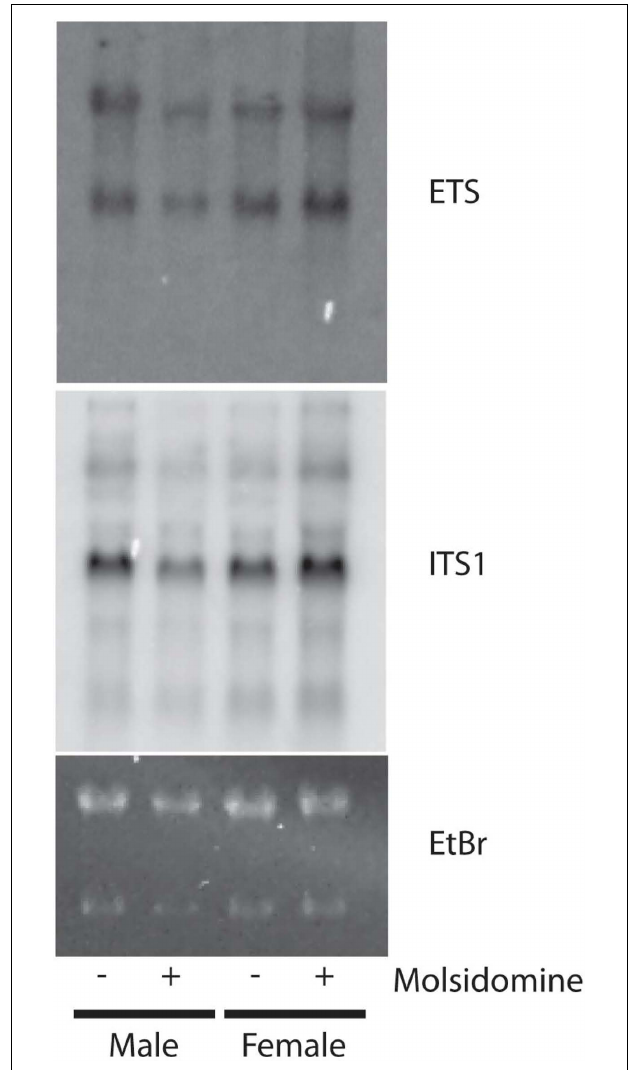
FIGUREA2 | Northern Blots. Northern blotting was performed on kidneys from 2week FHH in order to determine rates of pre-rRNA processing. ETS: external transcribed spacer. ITS1: internal transcribed spacer 1. Ethidium bromide (EtBr) is shown as loading control. Note the slight decrease of molsidomine-treated males is due to loading (seen by EtBr) and not due to processing defects of pre-rRNA.